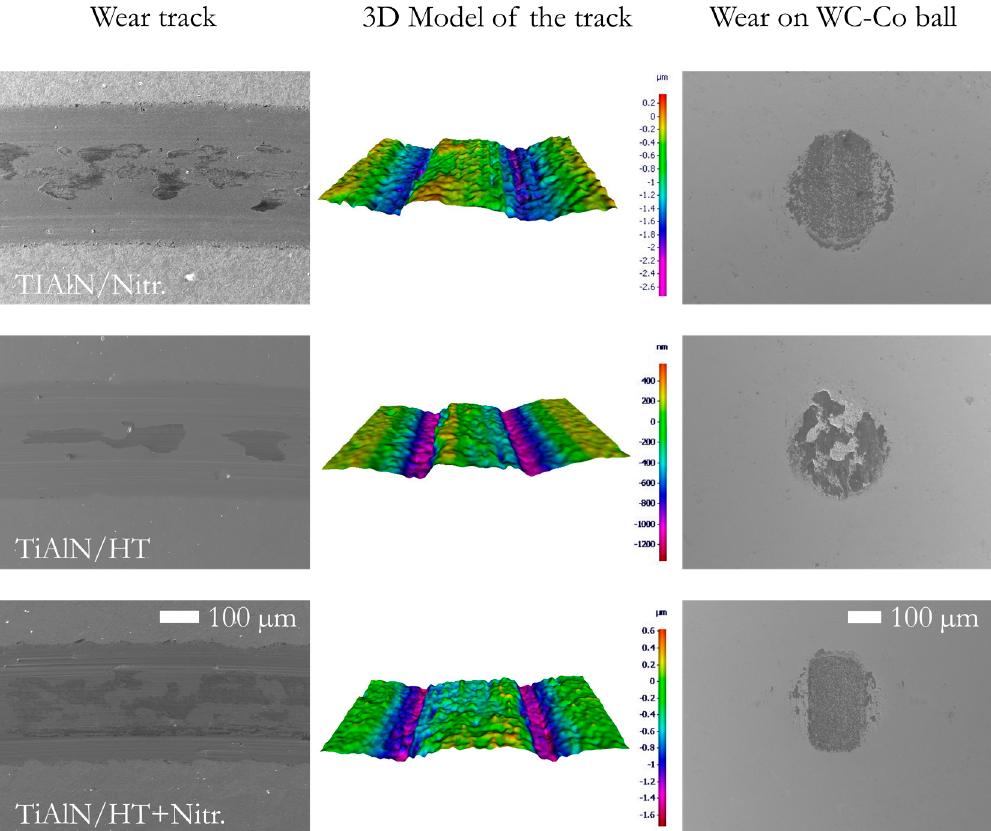
Figure 14. Wear tracks on the TiAlN coatings; SEM of the wear track (left), 3D Model (centre) and wear on the WC-Co ball (right).